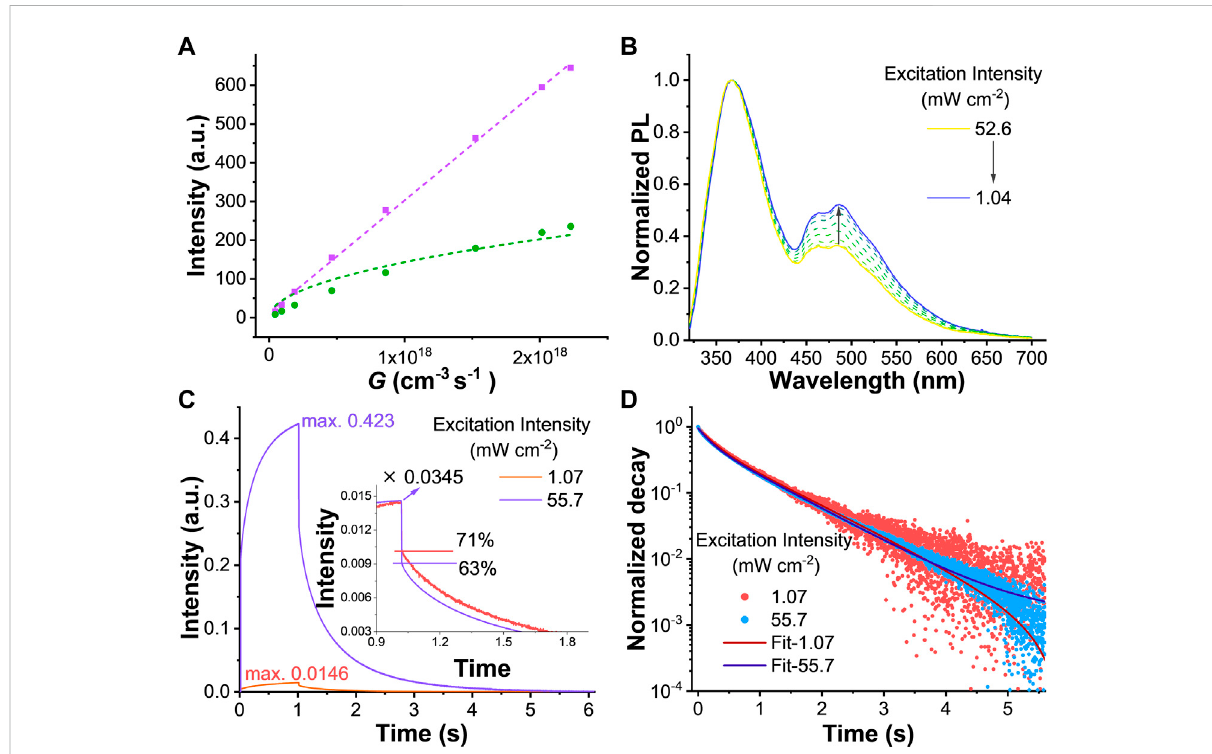
FIGURE 3 (A) Power dependent PL intensities are monitored at 366 (purple square) and 484 (green triangle) nm. Purple dash line is obtained from a linear fi twhilegreendashlineresultsfromaglobal fi tusingEq.5 (B) NormalizedPLspectraofZnIPAunderdifferentexcitationpower (C) Time-resolvedPL spectra ofZnIPA underdifferentexcitation power. Theinsertisazoomedspectra with time rangefrom 0.9to 1.9 s. A500 nm longpass fi lter issetup before the detector to remove the most parts of fl uorescence (D) Normalized decay spectra of ZnIPA, the fi tting lines are obtained using a biexponential method. All the samples are under excitation of 300 nm